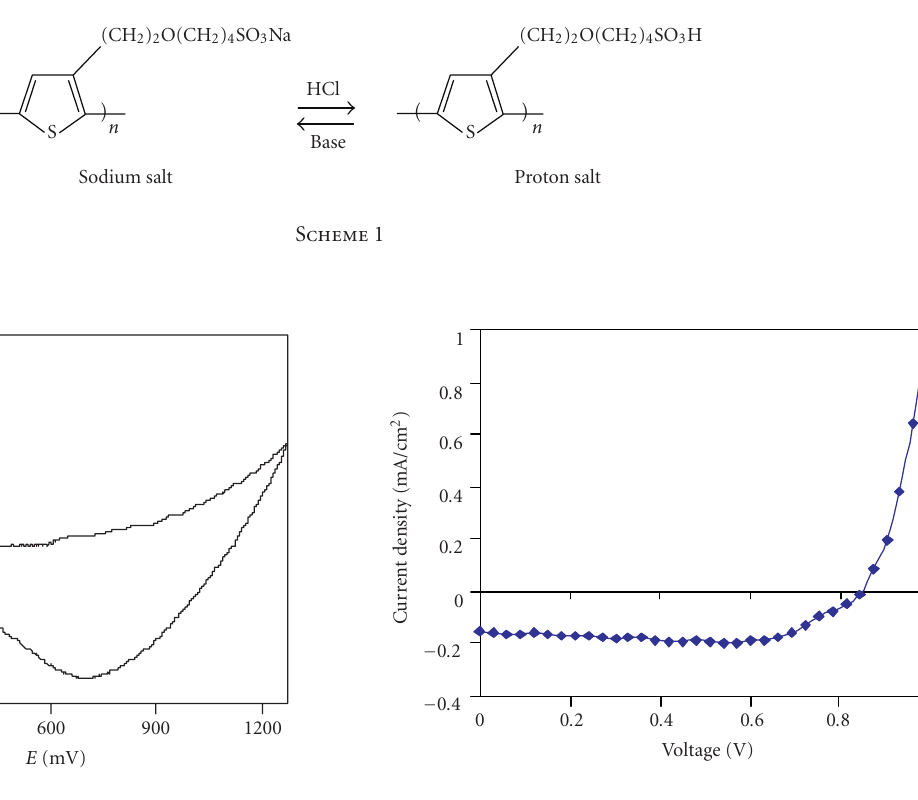
Figure 5: J-V curve for PTEBS bilayer solar